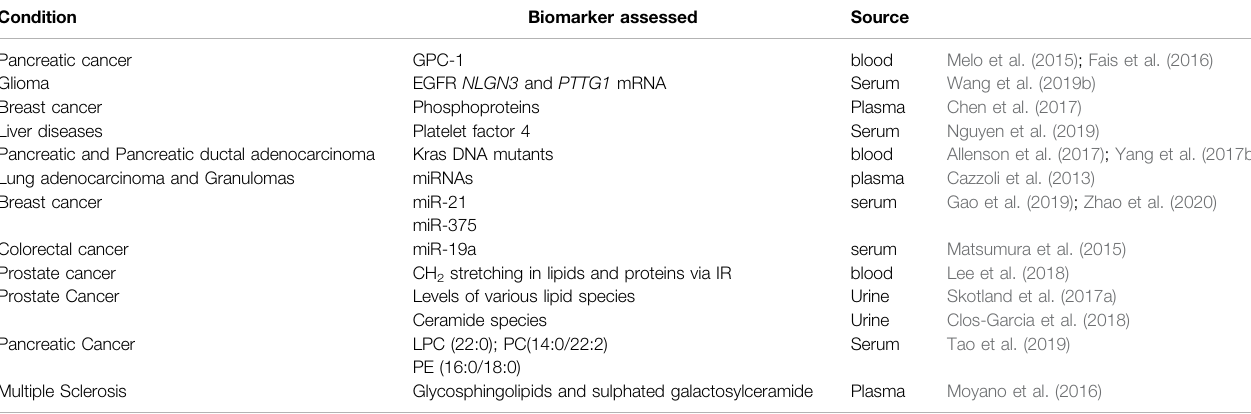
TABLE 1 | Membrane Vesicle Based Biomarkers in various cancer